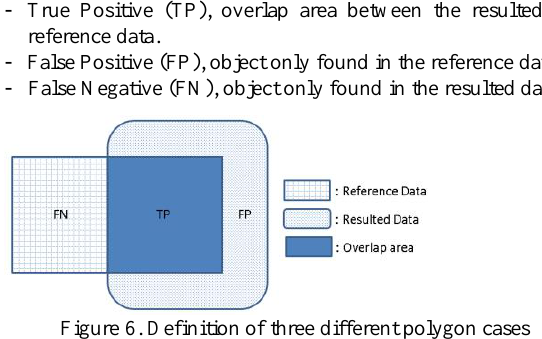
Figure 7. Comparison of buildings polygons